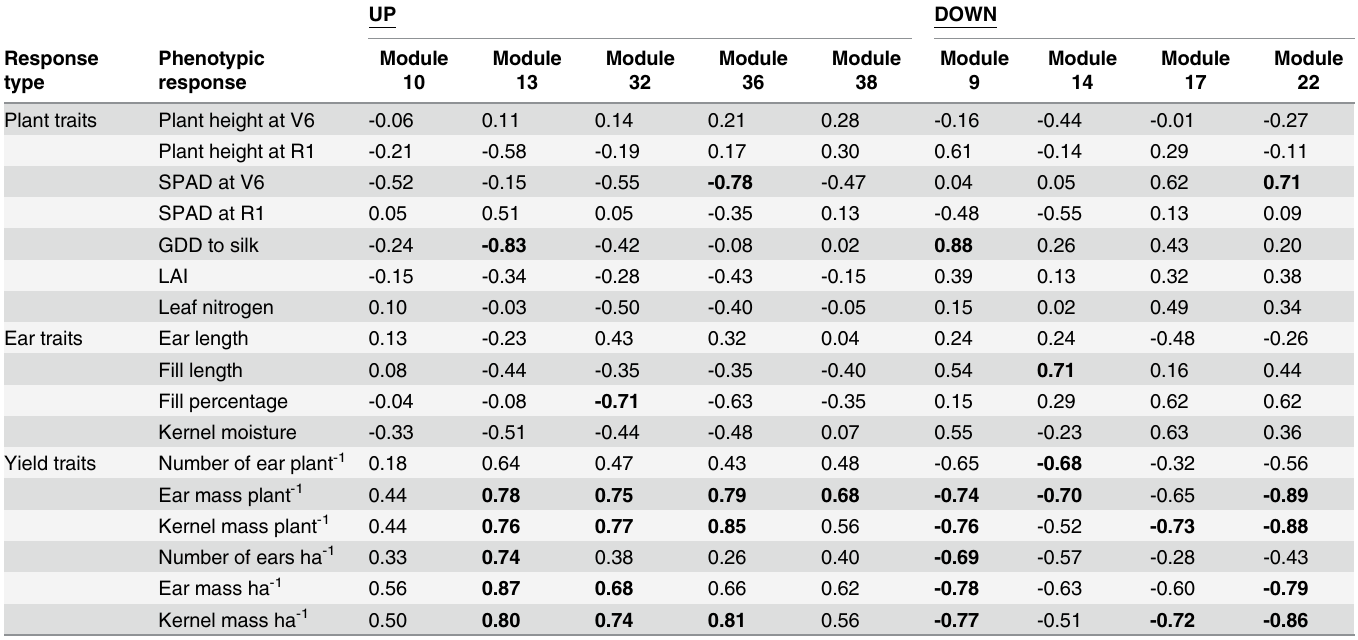
Table 6. Correlation coefficients between phenotypic traits and modules with significant expression differences between high- and low-yielding groups. Correlation coefficients with bold text significant at FDR p-value < 0.05. UP DOWN